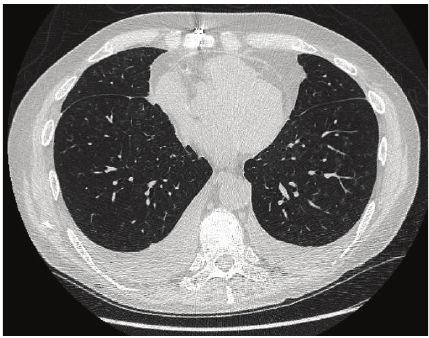
Figure 1: High-resolution axial computed tomography scan of the chest shows ground-glass centrilobular nodules before initiation of everolimus therapy.